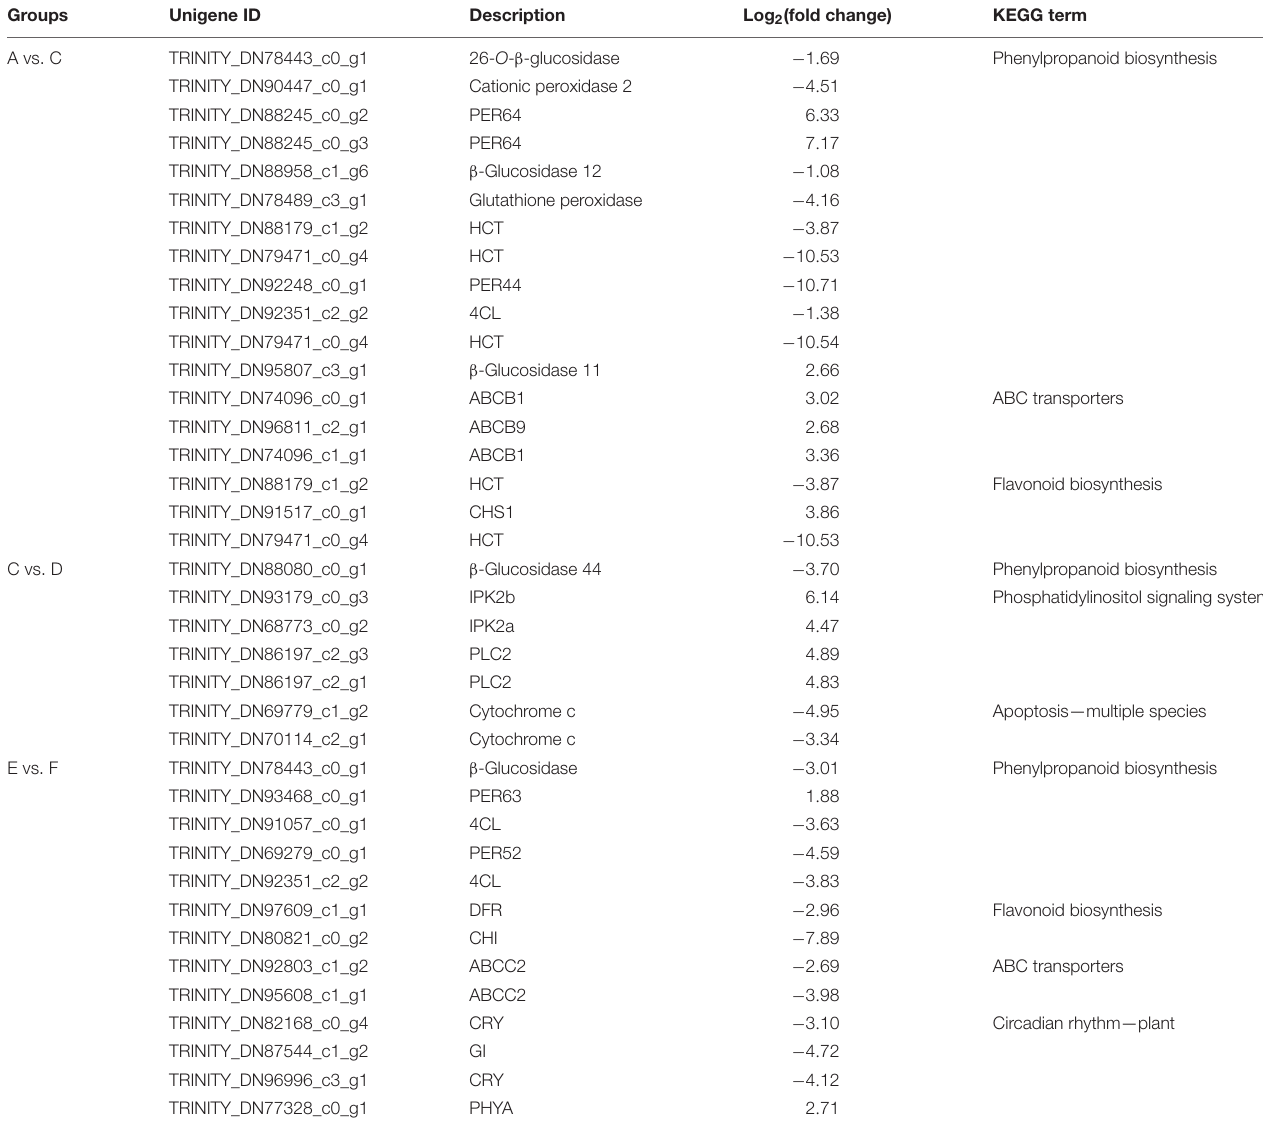
TABLE 3 | The significantly different genes between